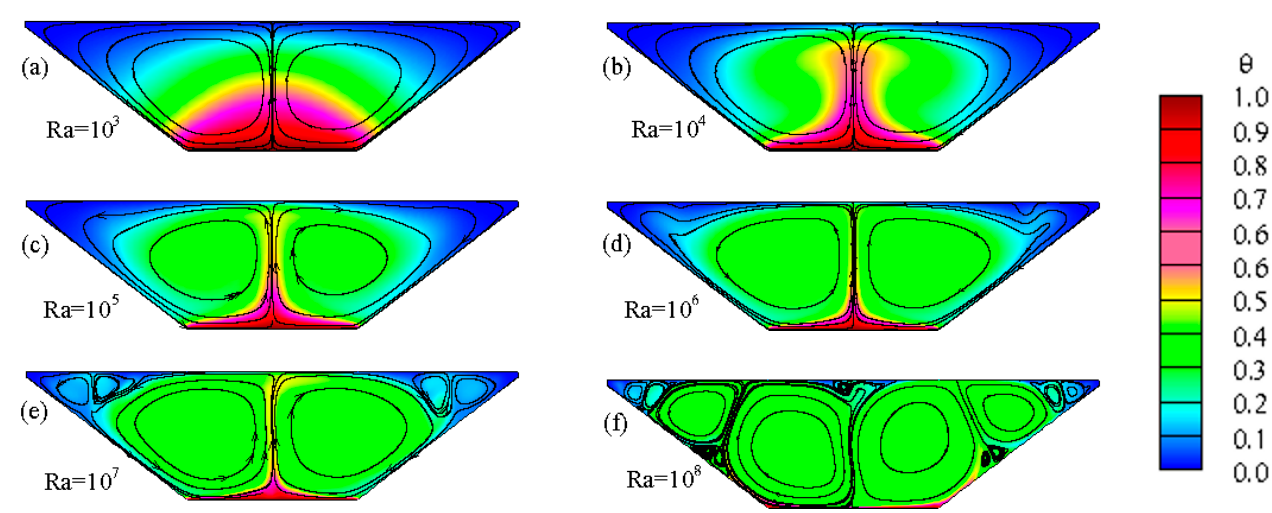
Figure 6. Streamlines and isotherms at the developed transitional stage for the different Rayleigh numbers ( a ) Ra = 10 3 , ( b ) Ra = 10 4 , ( c ) Ra = 10 5 , ( d ) Ra = 10 6 , ( e ) Ra = 10 7 , ( f ) Ra = 10 8 , at τ = 100.